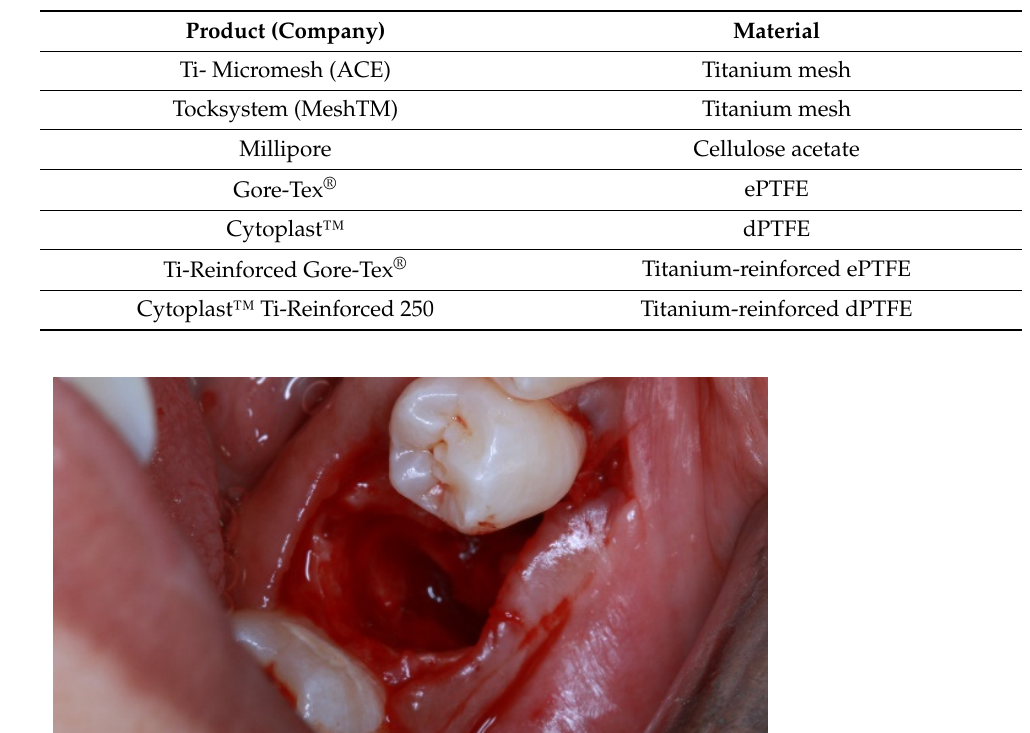
Table 1. Commercially available non-resorbable barrier membrane.